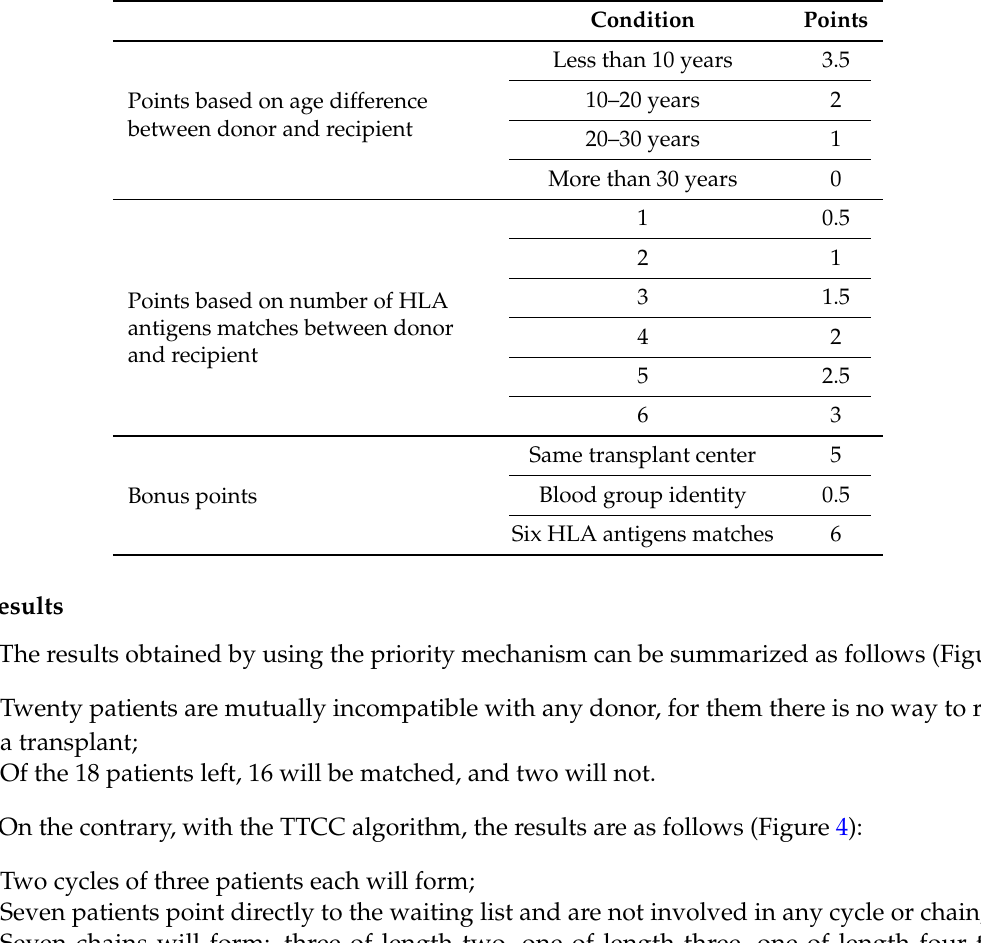
Condition Points Less than 10 years 3.5 10–20 years 2 20–30 years 1 More than 30 years 0 1 0.5 2 1 3 1.5